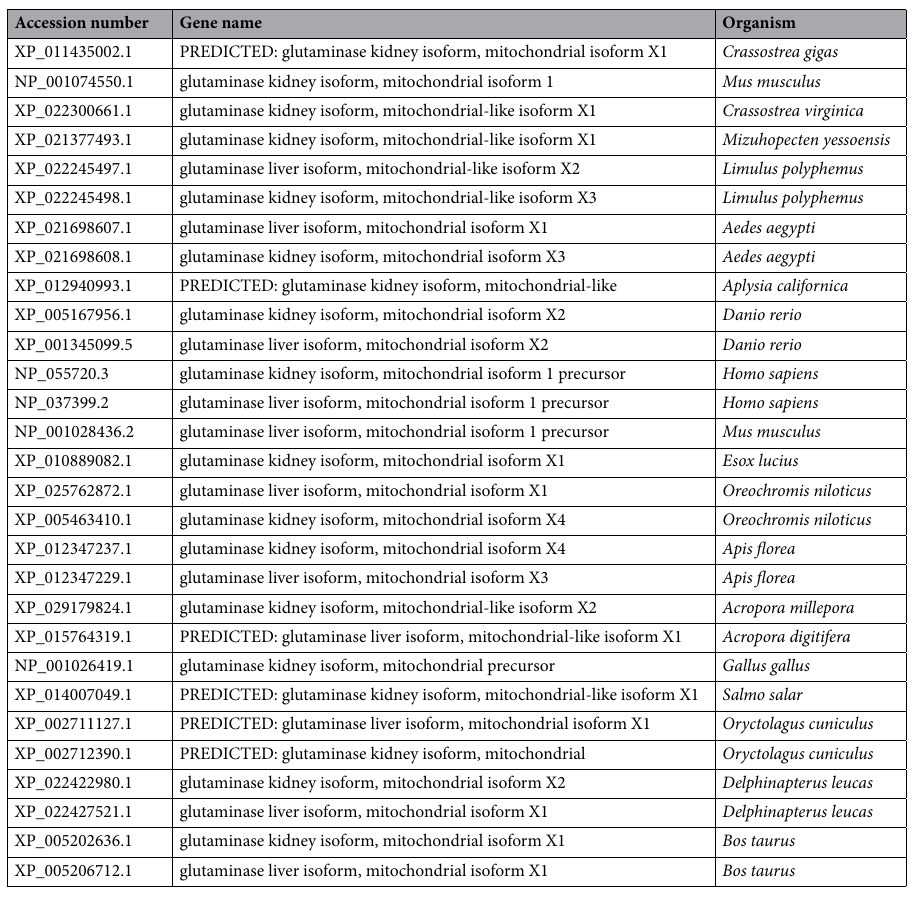
Table 2. Sequences used for the Cg GLS-1 alignment and phylogenetic